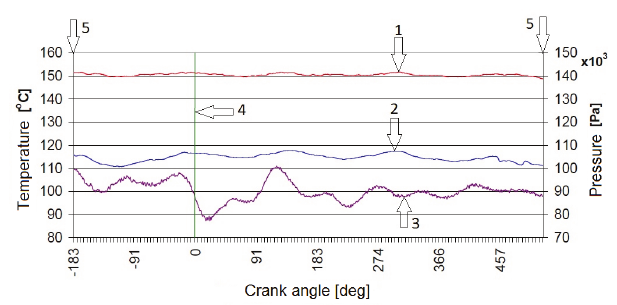
Fig. 6. Curves and changes of temperatures recorded with the two type K thermocouples during a single work cycle after mathematical processing in Matlab (envelope); 1 – temperature recorded with the exposed thermocou- ple after mathematical processing, 2- temperature recorded with the water- cooled thermocouple after mathematical processing, 3 – pressure in the exhaust channel, 4 – exhaust valve closing signal, 5 - exhaust valve open- ing